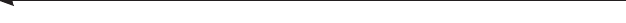
Figure 4: Demonstrations of waveguide lasers based on 2D materials. (A) Prototype and spatial configuration of the monolithic mode-locked waveguide laser based on the ReSe saturable absorber. The total 2 cavity length of the monolithic laser resonator is around 11 mm. (B) The average output power as a function of the launched power and the emission spectrum of the waveguide laser modulated by ReSe . The inset is the measured near-field modal profile of the output laser (A and 2 B reproduced from [120] with permission from APL Photonics). (C) Schematics of a microdisk cavity, consisting of a microdisk with a radius of r and height of h , supported by a PMMA (poly(methyl methacrylate)) post. The disk-shaped scatterer with a radius of r a located at the d d s edge of the microdisk (C reproduced from [126] with permission from ACS Photonics). (D) Design of the waveguide-integrated LED. In the LED mode, the light emitted from the p-n junction propagates through the waveguide and is coupled out at the grating coupler. Cross-sectional schematic of the encapsulated bilayer MoTe p-n junction on top of a silicon photonic-crystal waveguide. The carrier concentration in MoTe 2 2 is controlled by the split graphite gates, the separation of the two gates is 400 nm, the dielectric layer is h-BN on top of the MoTe , and the 2 thickness is 80 nm. The source (s) and drain (d) electrodes are thin graphite flakes connected to Cr/Au leads. (D reproduced from [127] with permission from Nature Nanotechnology.) (E) Crystal structure of MoTe . Schematic of the device (the Si photonic crystal nanobeam laser 2 structure suspended in air with a monolayer MoTe on top) (E reproduced from [122] with permission from Nature Nanotechnology). 2 (F) Schematic of a MoTe -on-Si nanolaser, where the far-field optimized silicon photonic-crystal cavity is the resonator, and the trilayer 2 MoTe is the gain material (F reproduced from [123] with permission from Journal of the Korean Physical Society). (G) 3D schematic image 2 of the fabricated MoS /WSe heterobilayer-photonic crystal cavity nanolaser (G reproduced from [128] with permission from Science 2 2 Advances). (H) Schematic diagram of the hBN-MoTe -hBN sandwich placed on the silicon single-mode cavity. A few-layer-thick flake of MoTe 2 2 provides the optical gain. The MoTe flake is sandwiched between two layers of hBN and is placed on the cavity (H reproduced from [125] 2 with permission from Advanced Optical